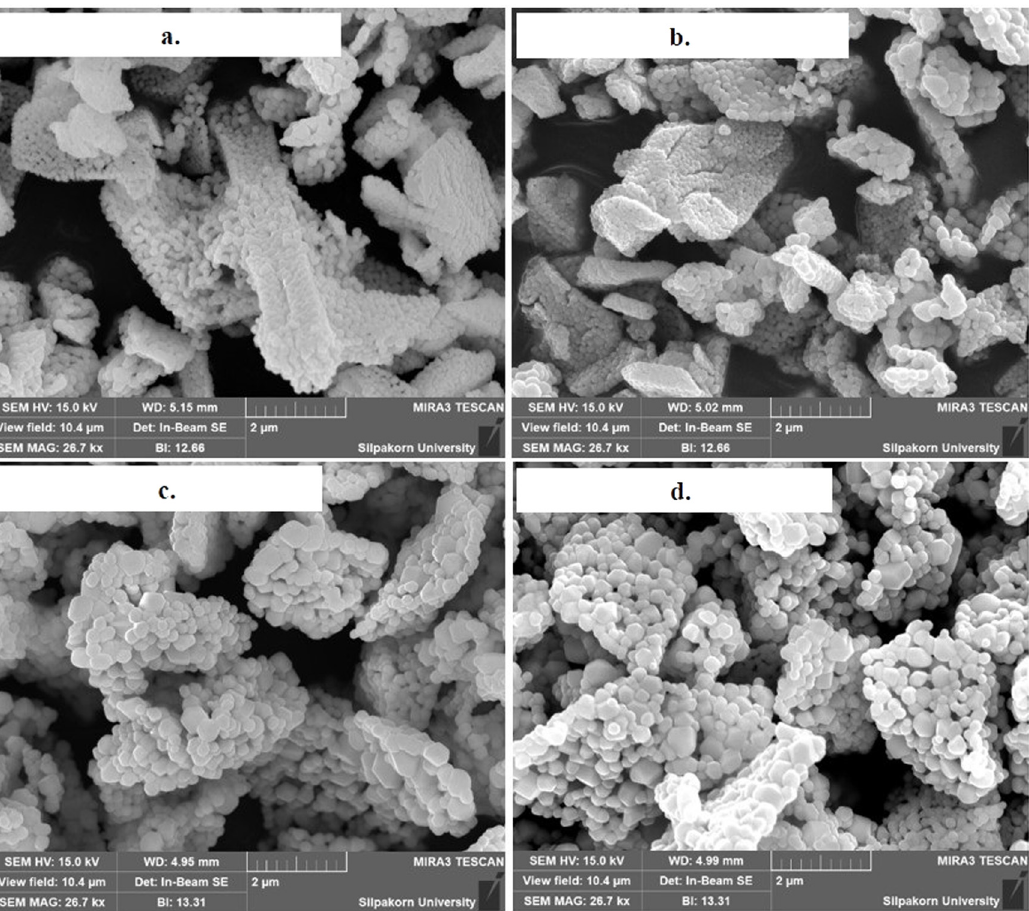
Figure 8: SEM micrograph ( 26,700 × magni fi cation ) of CeO 2 : ( a ) 3% oxalic before reaction, ( b ) 3% oxalic after reaction ( the sample in ( a ) and ( b ) used 400 rpm stirring rate ) , ( c ) 400 rpm before reaction, and ( d ) 400 rpm after reaction ( the samples in ( c ) and ( d ) used 3% oxalic concentration )